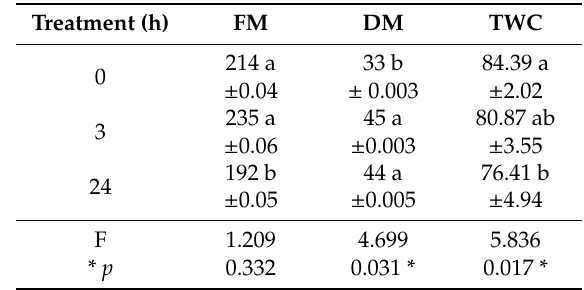
Table 3. Fresh, dry masses, and tissue water content of triticale ( × Triticosecale Wittm. ex A.Camus) seedlings irradiated with a helium-neon (He-Ne) laser by 3 and 24 h; mean ± SD (n = 10) values marked with di ff erent letters di ff er statistically according to Tukey’s test at * p ≤ 0.05.